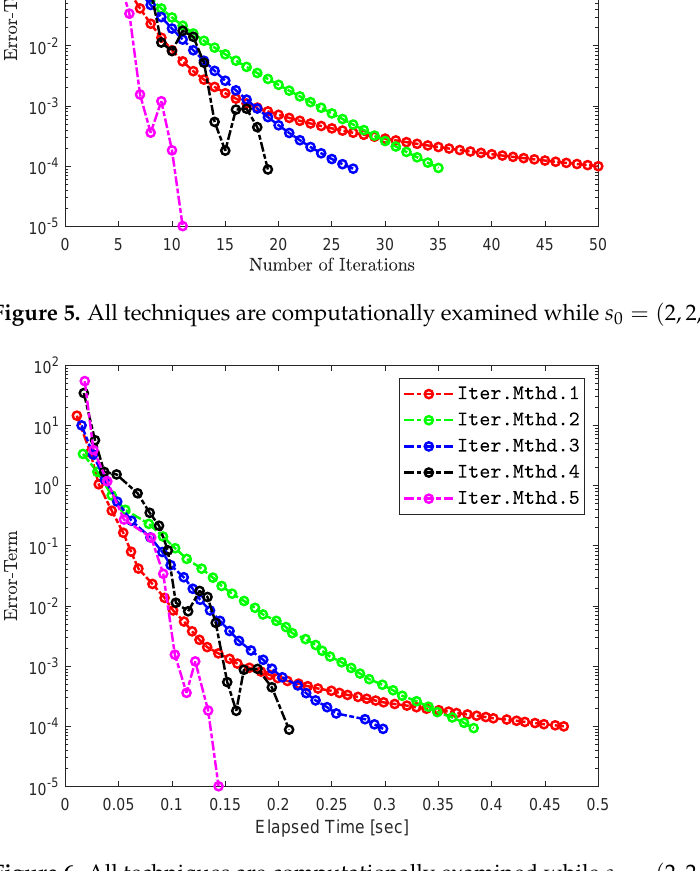
Figure 6. All techniques are computationally examined while s 0 = ( 2,2,3, − 4,4 ) T .